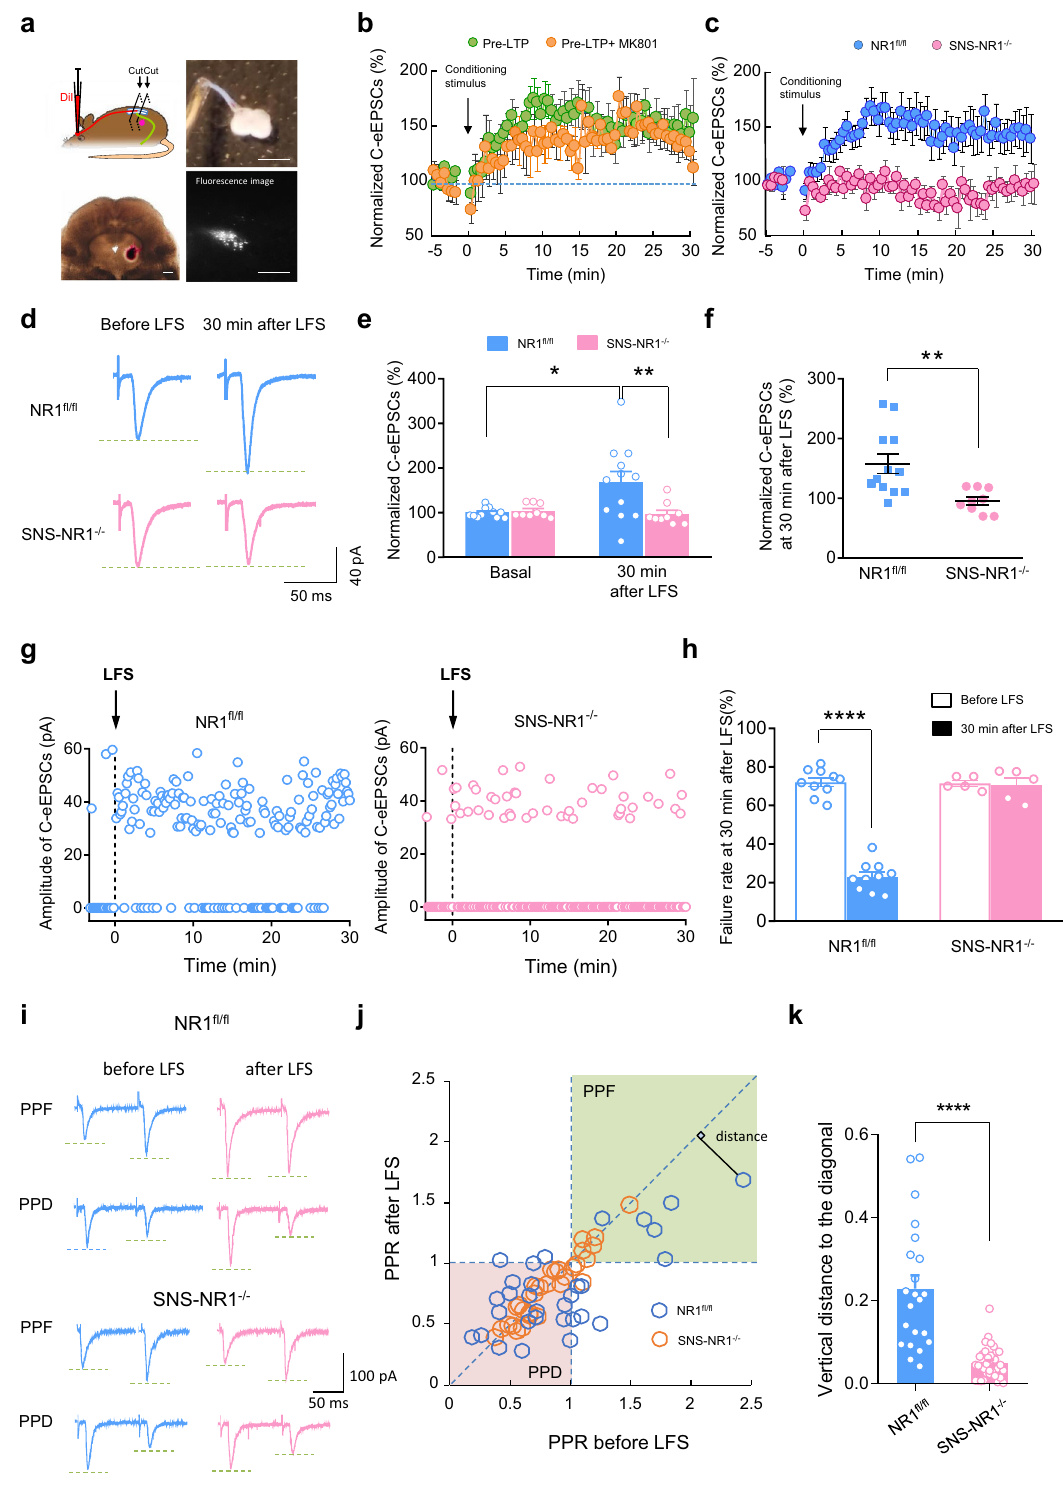
nociceptors and spinal-PAG projection neurons comes about via presynaptic mechanisms largely involving an increase of release probability via PreNMDARs. Evidence for a role of PreNMDARs on exogenous NMDA- induced modulation of synaptic transmission . To further con- fi rm the key role of PreNMDARs on spinal synaptic plasticity, we